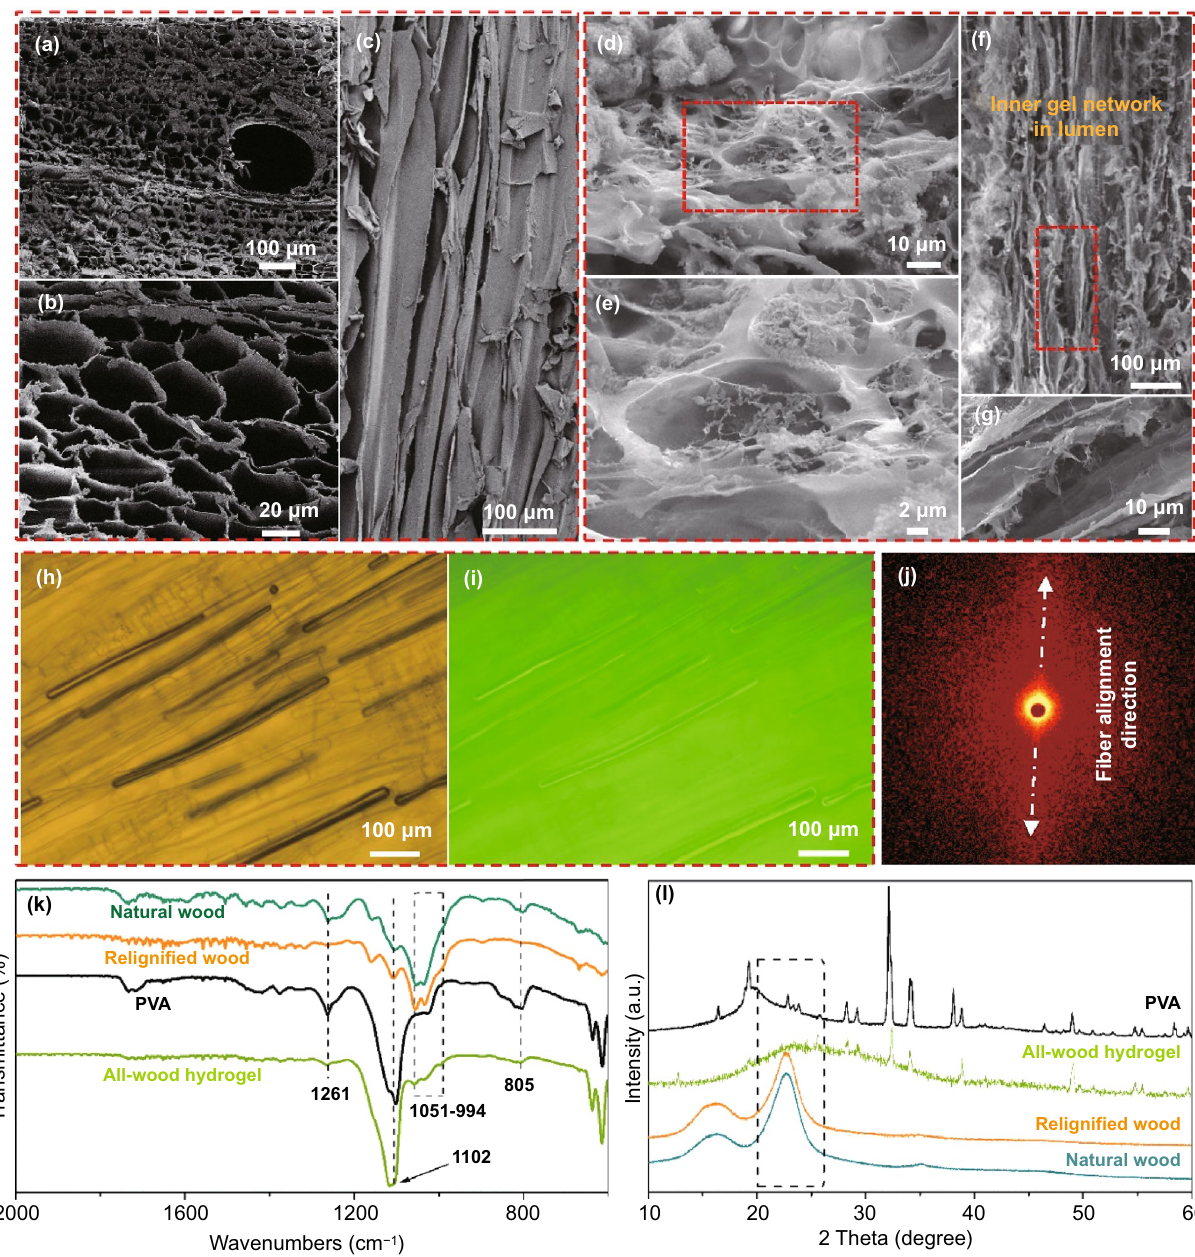
Fig. 2 Morphological and structural characterizations of natural wood and all-wood hydrogels. SEM images of the natural wood: a the top-view SEM image and b its magnified image, and c the side-view SEM image of natural wood. SEM images of the all-wood hydrogel: d the top-view SEM image and e its magnified image, f the side-view SEM image and g its magnified image. h , i Confocal images showing the penetration of PVA into the microchannels of the all-wood hydrogel. Scale bar, 100 μm. j SAXS pattern of the prepared all-wood hydrogel. k FTIR spectra and l XRD patterns of the PVA, relignified wood, and all-wood